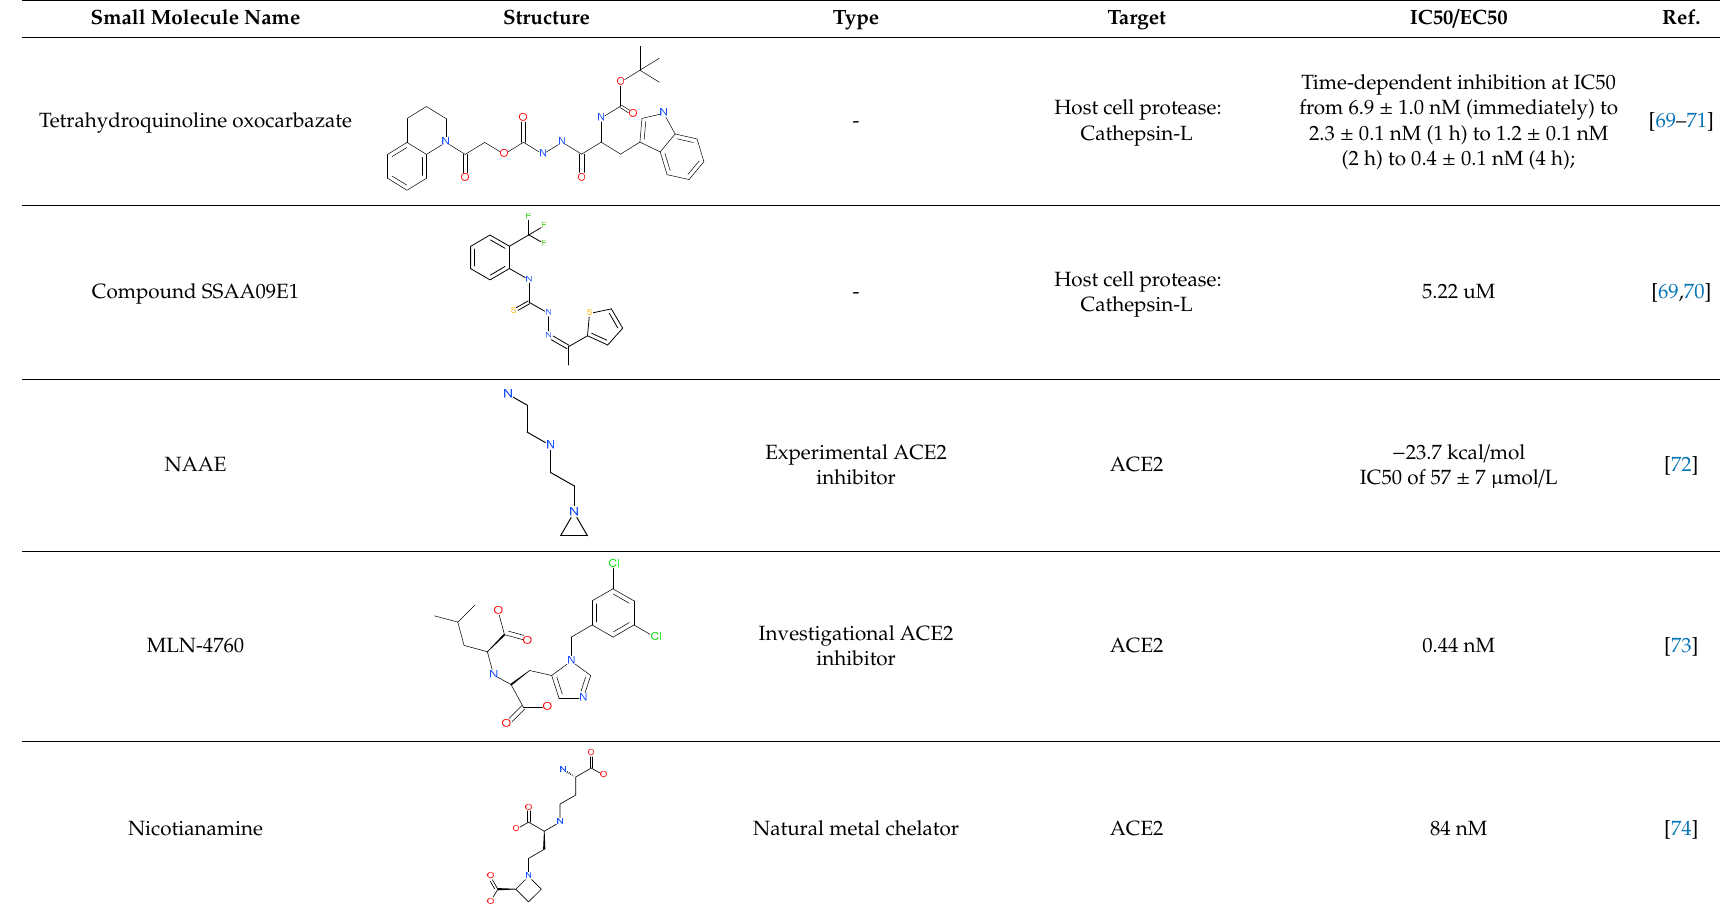
Table 5. Small molecules identified through computational approaches for targeting host ACE2.